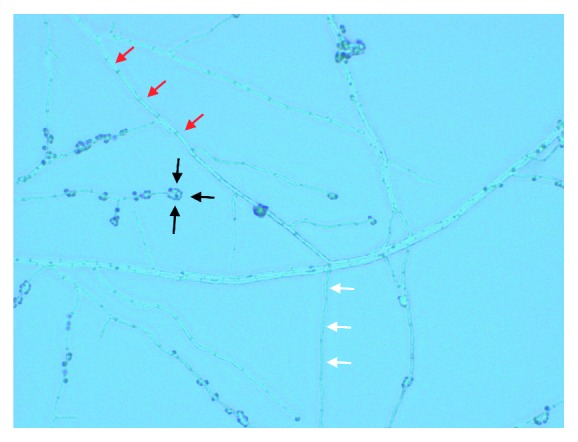
A hyphal form of Sporothrix schenkii from synovial fluid aspirate cultured on Sabouraud agar. Narrow branching hyphae (red arrows) giving rise to slender conidiophores (white arrows) at right angles. The apex of conidiophores is covered with tear-shaped conidia in a rosette-like fashion (black arrows). Single conidia can also be formed along the hyphae.